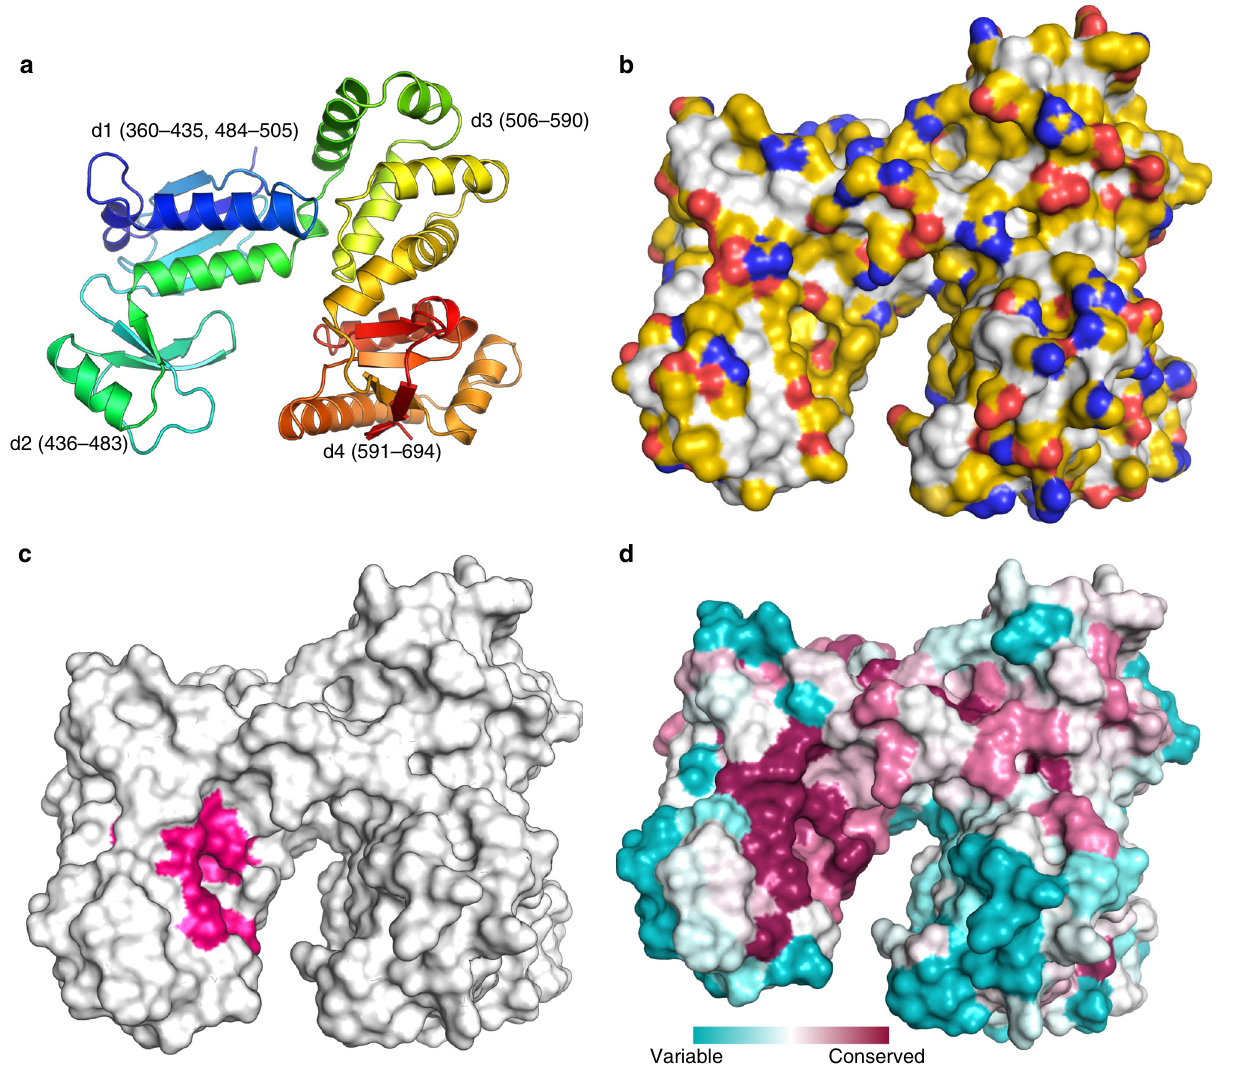
Fig. 2 Structural properties of the export gate protein FlhA C . a Cartoon rendering of the crystal structure of FlhA C determined at 1.9 Å resolution. The protein is colored using a continuous-gradient color scheme from the N terminus (blue) to the C terminus (red). b Solvent-exposed surface rendering of FlhA C displayed in the YRB color scheme 59 (yellow, carbons not attached to nitrogen or oxygen; red, negatively charged; blue, positively charged). c The FlhA C site determined by NMR to interact with its binding partners is highlighted in pink. d Sequence conservation of FlhA C colored according to residue identity conservation scores obtained by ConSurf 60 . The binding site is the most conserved surface in FlhA